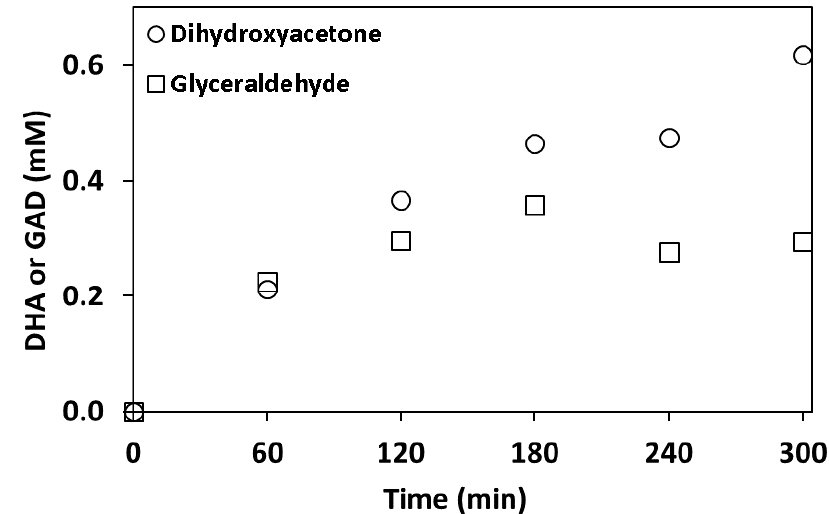
Figure 6. Photocatalytic reaction of glycerol in a mixture of hexane and water under simulated solar light. The concentration of DHA and GAD in the water phase over time. Glycerol concentration over time is shown in Figure S7. Water: 10 mL, hexane: 90 mL, glycerol: 0.4 mmol, Degussa P25 TiO 2 : 0.1 g.